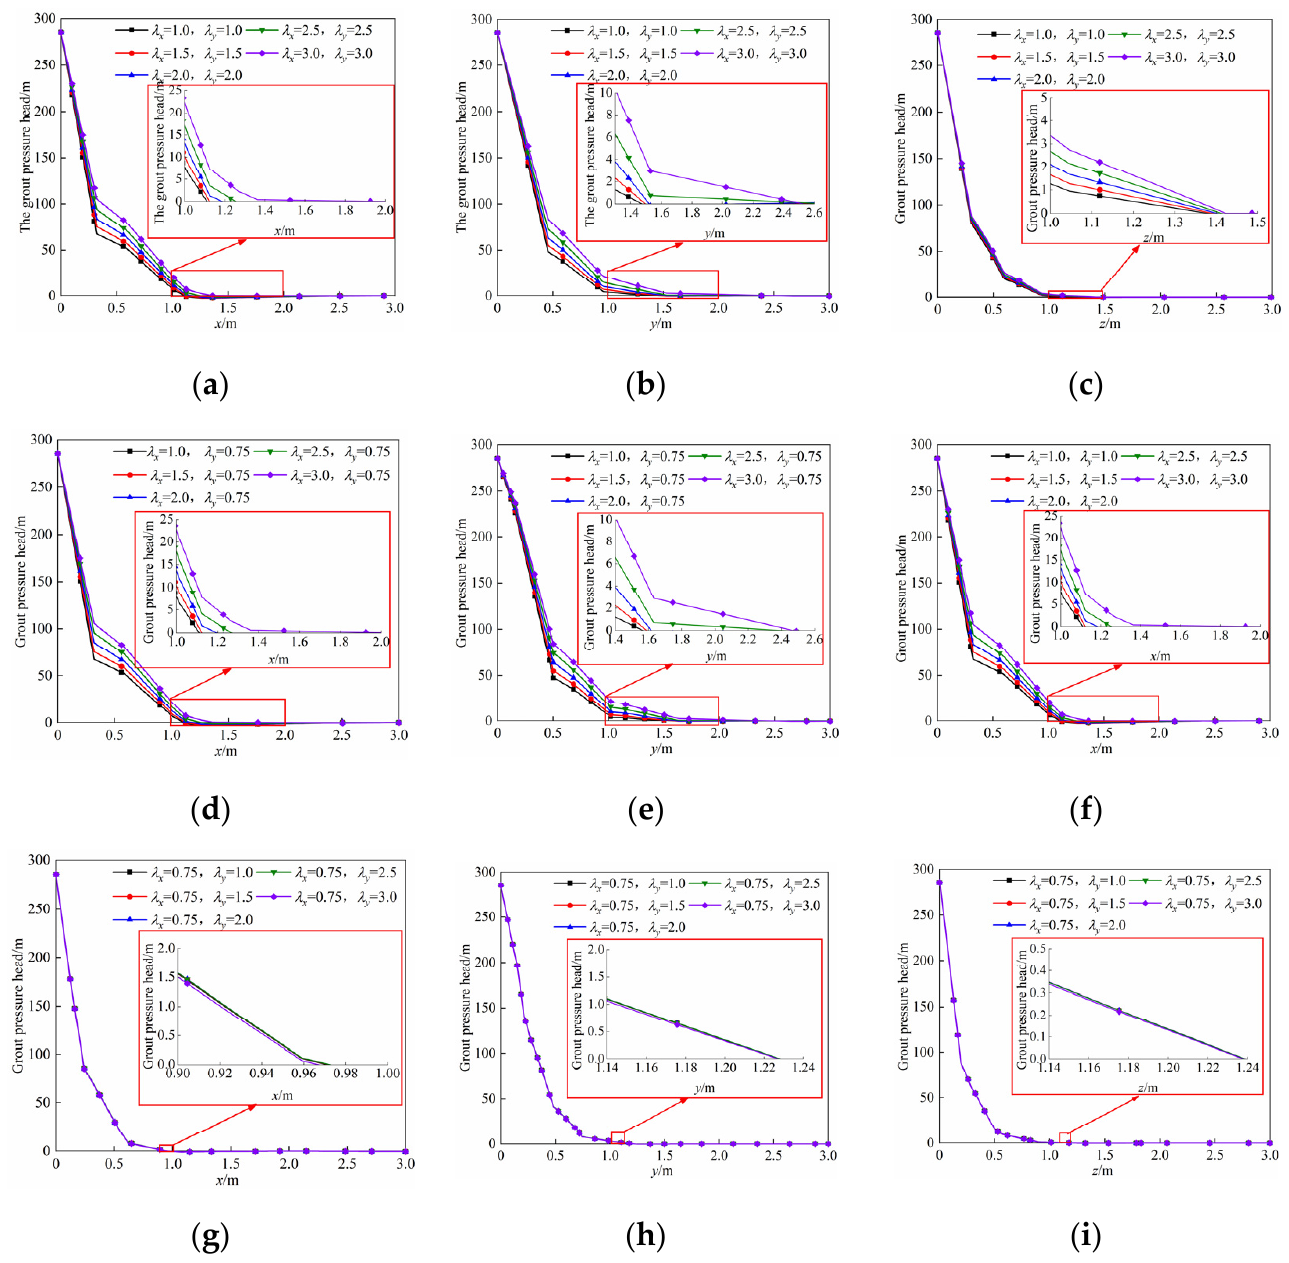
Figure 7. Change curve of grout pressure head with distance from the grouting borehole surface. ( a ) λ x = λ y , vertical borehole in x -direction; ( b ) λ x = λ y , vertical borehole in y -direction; ( c ) λ x = λ y , parallel borehole in z -direction; ( d ) λ x > λ y , vertical borehole in x -direction; ( e ) λ x > λ y , vertical borehole in y -direction; ( f ) λ x > λ y , parallel borehole in z -direction; ( g ) λ x < λ y , vertical borehole in x -direction; ( h ) λ x < λ y , vertical borehole in y -direction; ( i ) λ x < λ y , parallel borehole in z -direction.